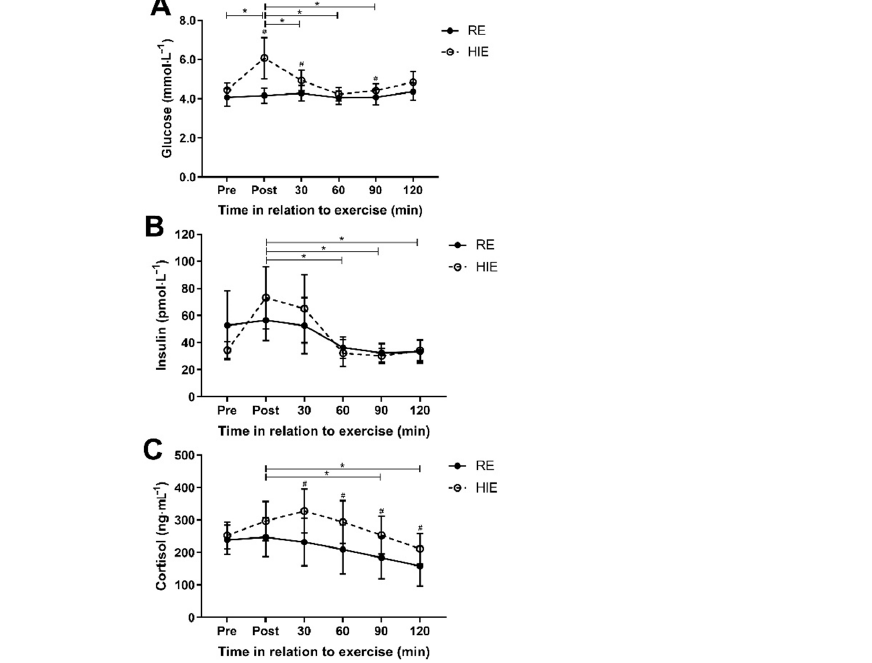
Figure 2. Responses to high-intensity interval exercise (HIE) and resistance exercises (RE) for plasma glucose ( A ), plasma insulin ( B ) and plasma cortisol ( C ). Data shown are mean and 95% CI. # Indicates a post hoc difference between exercise mode after a significant interaction effect was identified ( p < 0.05). * Indicates a significant pairwise comparison after Bonferroni correction ( p < 0.05) tested after a significant main effect for time was identified. Time of measurements were immediately pre- and post-exercise, and then 30, 60, 90 and 120 min after the completion of exercise. A significant interaction effect for HR response (f = 11.2 (3.6) , p < 0.001; η p2 = 0.45) and RPE response (f = 7.7 (3.1) , p < 0.001; η p2 = 0.36) was present between trial and time. Mean